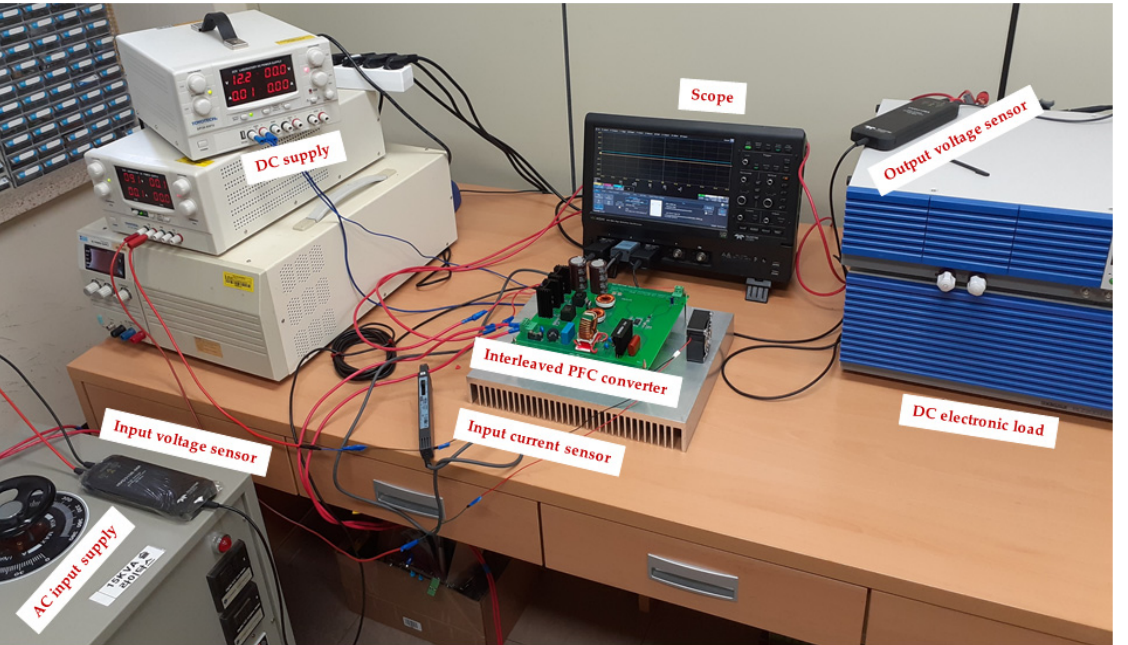
( d ) Figure 24. Input and output voltages, input current, and power factor of the designed conventional PFC converter with different loading condition. ( a ) 25%; ( b ) 50%; ( c ) 75%; ( d ) 100%. ( a )